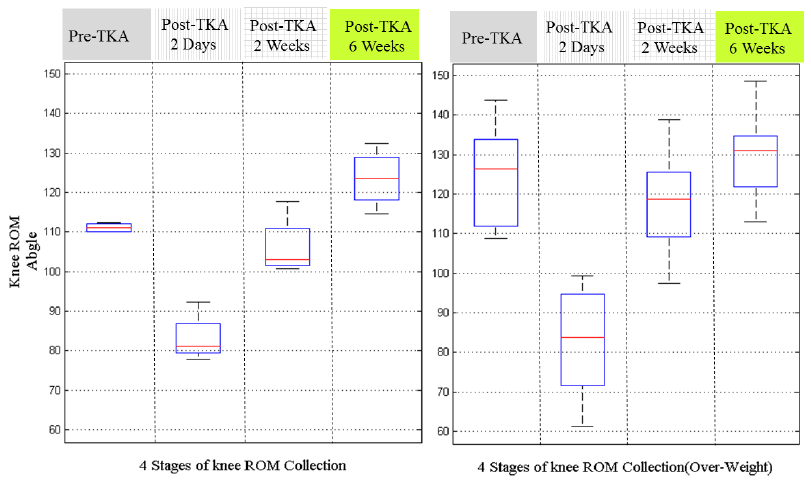
Figure 9. The recovery knee ROM between fat and thin patients (patients are grouped by BMI over and under 28).